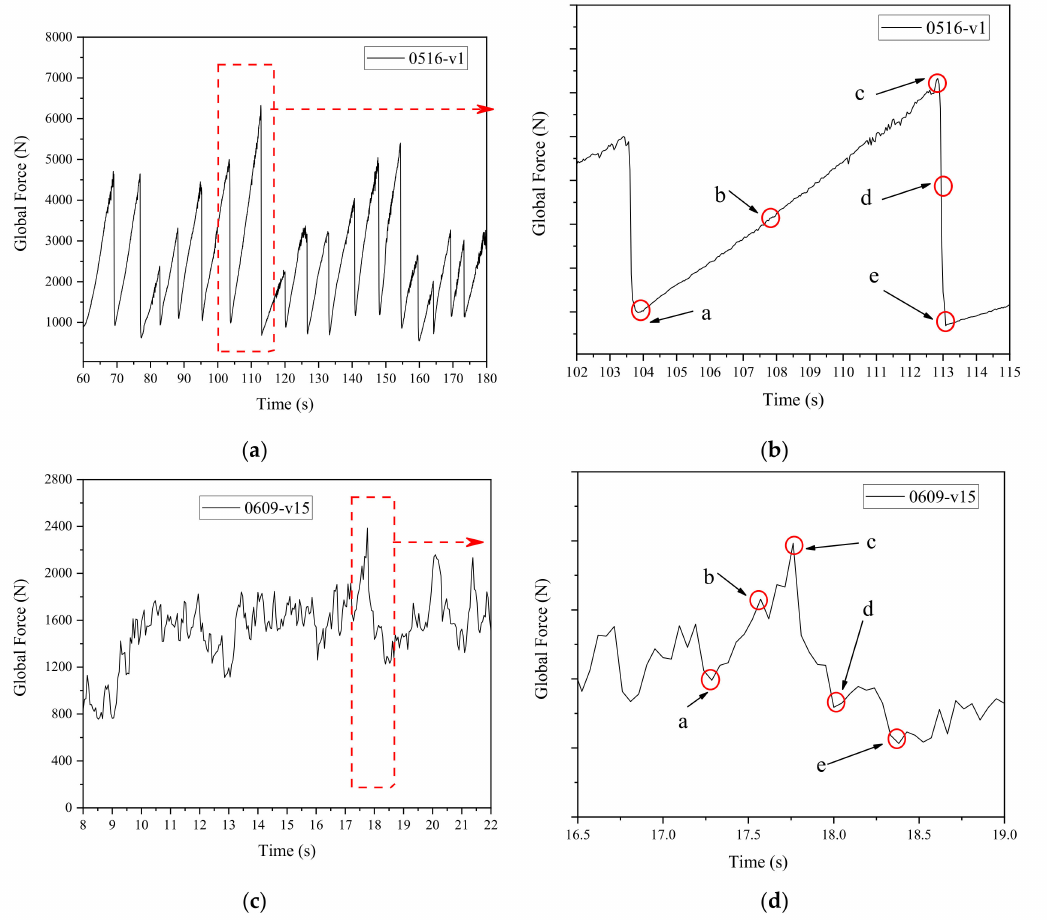
Figure 10. ( a ) Selected period from the global force when V load is 1 mm/s; ( b ) five selected moments when V load is 1 mm/s (a, b, c, d, e); ( c ) selected period from the global force when V load is 15 mm/s; ( d ) five selected moments when V load is 15 mm/s (a, b, c, d,